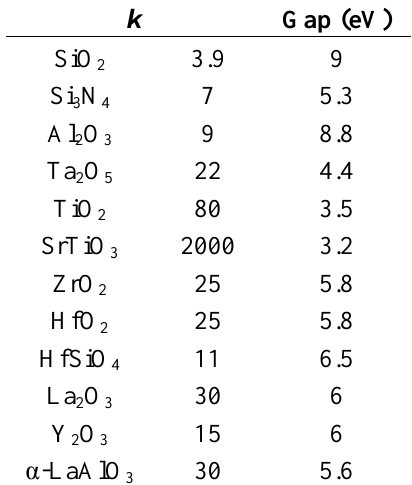
Table 2. Static dielectric constant k and experimental bandgap for gate dielectrics common in the literature (reproduced from ref.